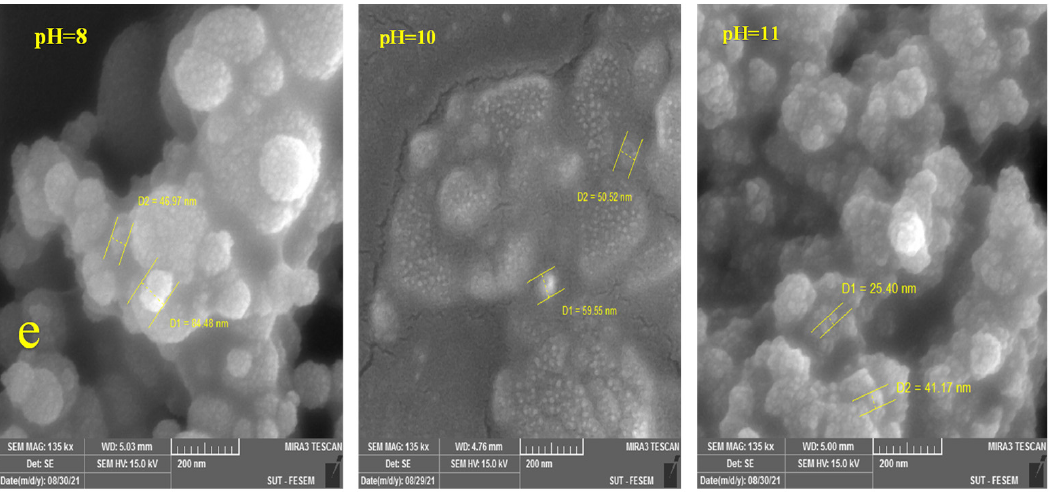
Figure 3. FESEM images of Cu 2 S thin films at different deposition parameters: ( a ) Deposition time (t d ), ( b ) bath temperature (T b ), ( c ) SC (NH 2 ) 2 concentration, ( d ) CuSO 4 .5H 2 O concentration, and ( e ) pH value.